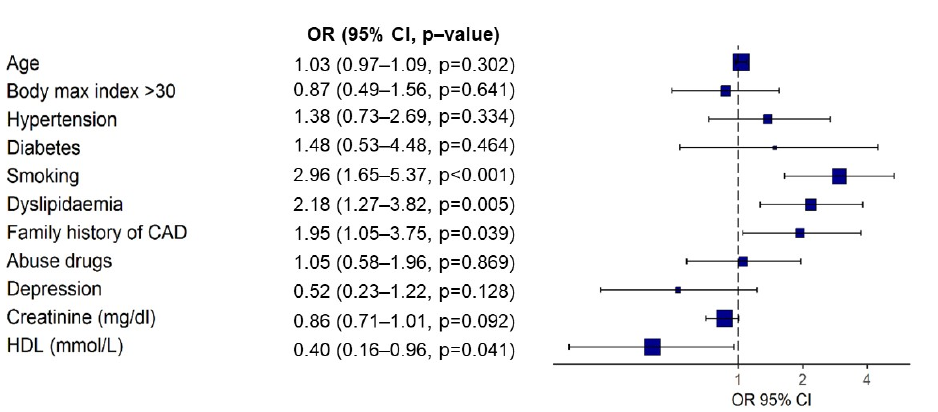
Figure 2. Multivariate logistic regression analysis of risk factors associated with significant CAD. CAD: coronary artery disease. HDL: high-density lipoprotein.